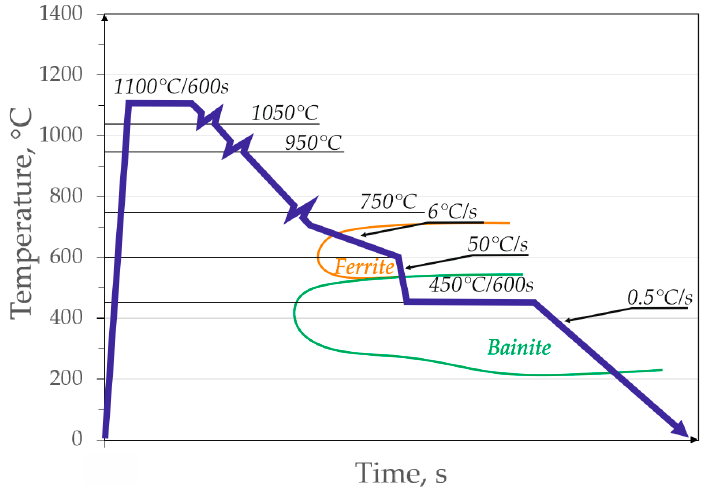
Figure 1. Scheme of thermomechanical processing of the investigated steel.